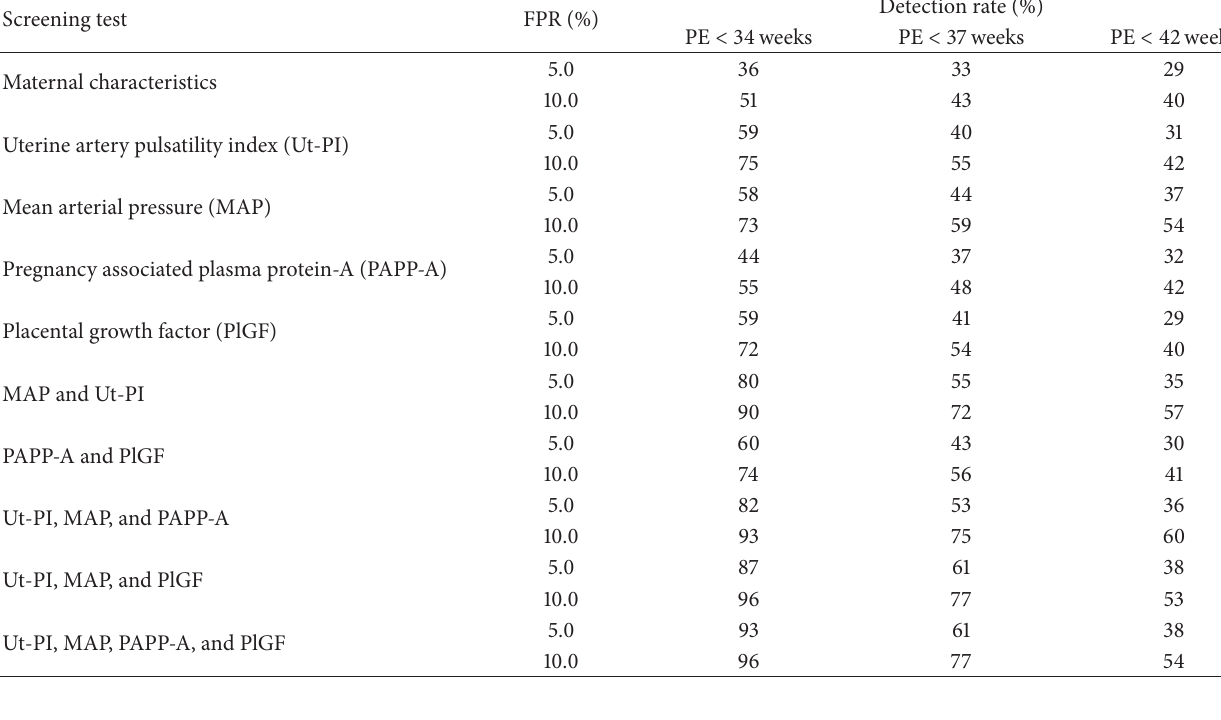
Table 1: Estimated detection rates of preeclampsia (PE) requiring delivery before 34, 37, and 42 weeks’ gestation, at false positive rates (FPR) of 5% and 10%.